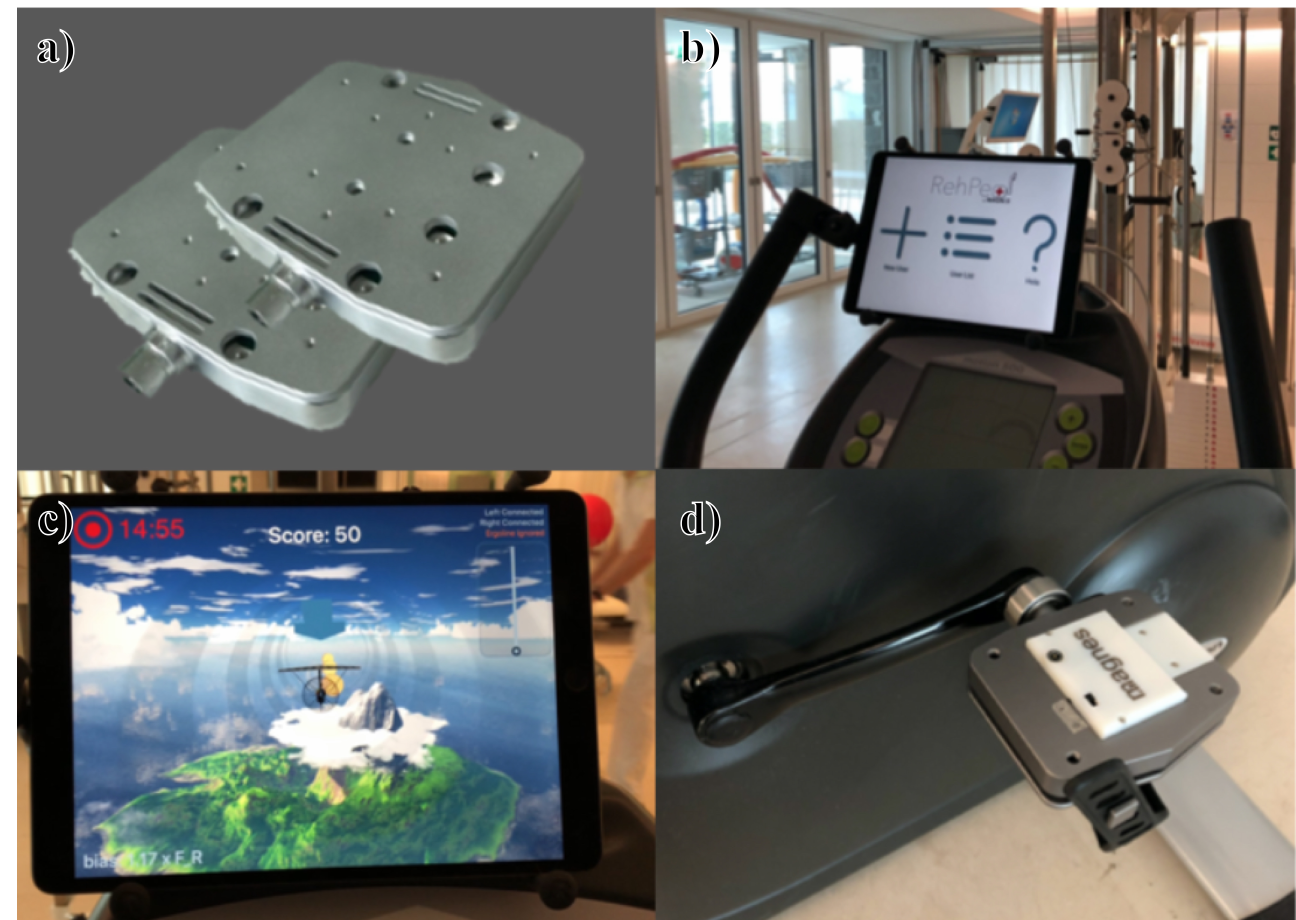
Figure 1. The developed ergometer-upgrade system. ( a ) 3D rendering of the sensor-equipped pedals; ( b ) The tablet mounted on an ergometer displaying the developed app’s home view; ( c ) In-game view of a training session; ( d ) One of the pedals installed on the ergometer—here, the pedal is upside